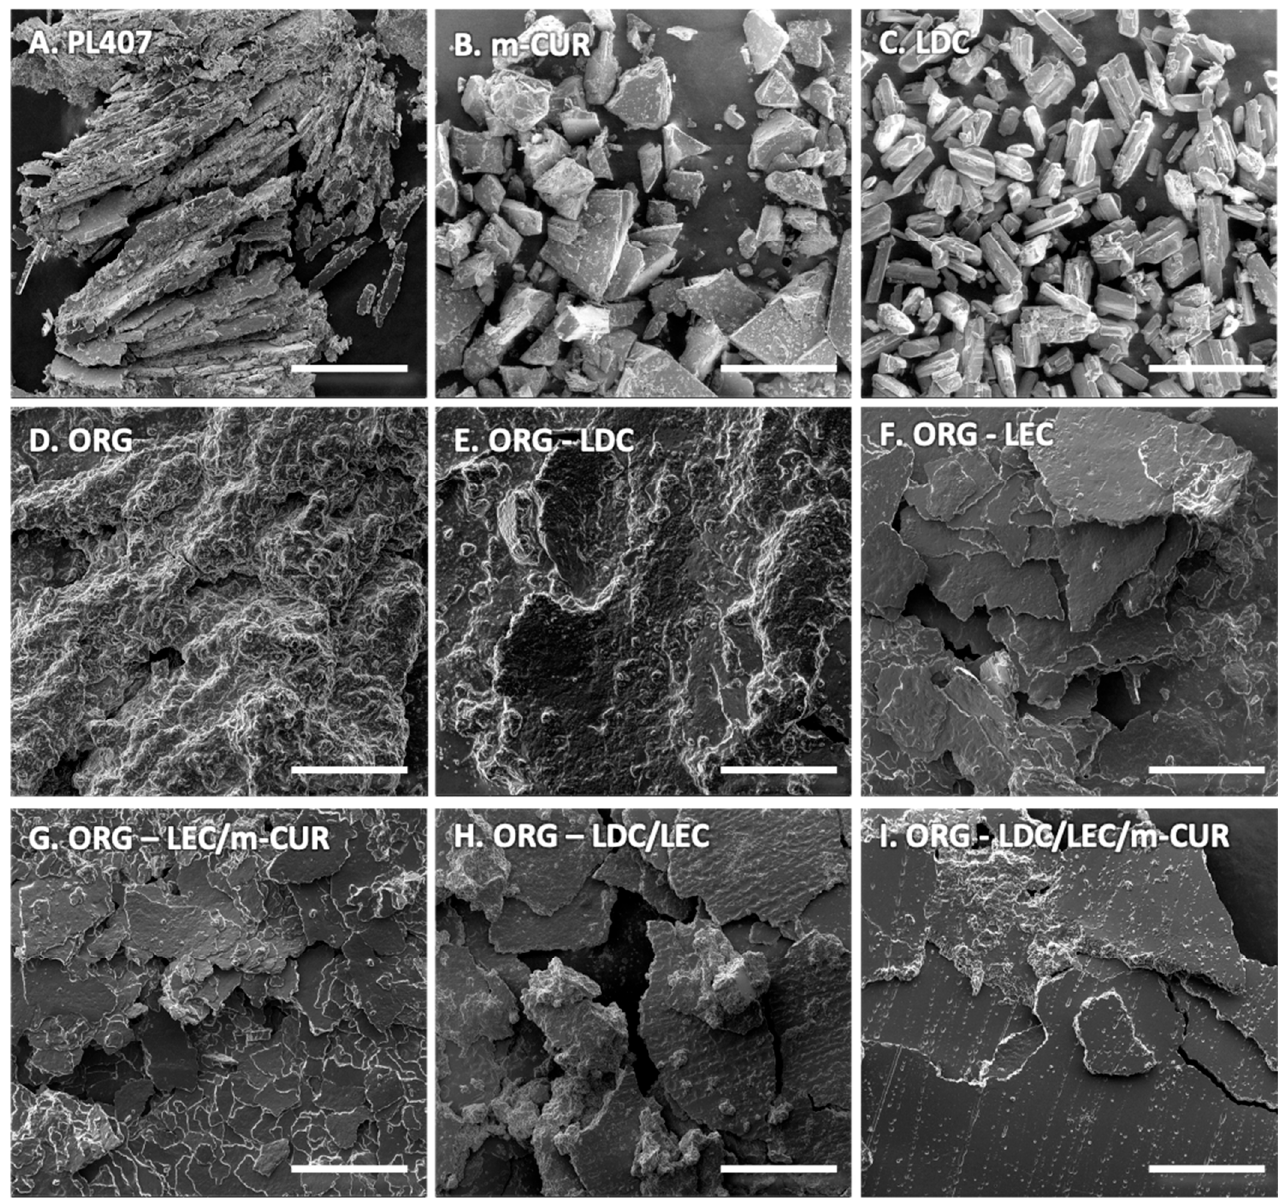
Figure 3. Representative scanning electron micrographs of the ( A ) PL407 hydrogel, ( B ) m-CUR, ( C ) LDC, ( D ) ORG, ( E ) ORG-LDC, ( F ) ORG-LEC, ( G ) ORG-LEC/m-CUR, ( H ) ORG-LEDC/LEC, and ( I ) ORG-LDC/LEC/m-CUR. Scale bar = 500 μ m.